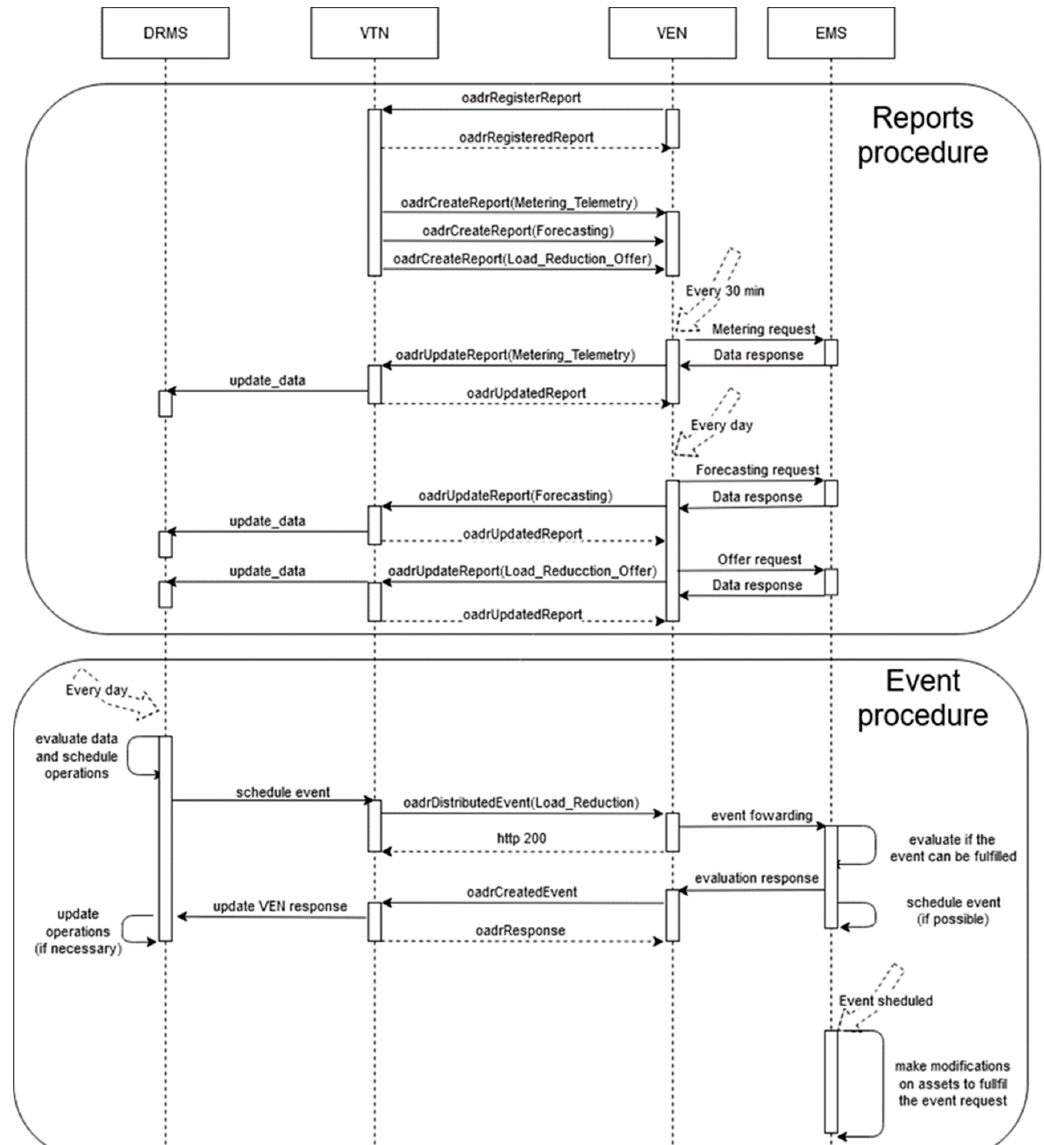
Figure 12. Sequence diagram of communication between VTN and VEN.